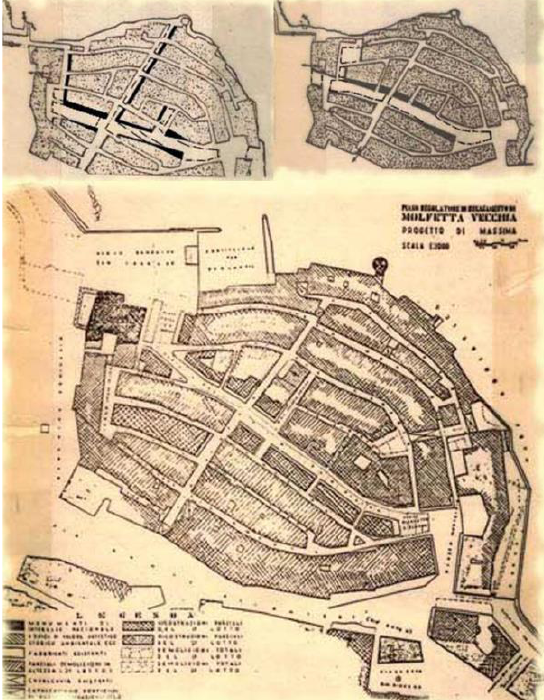
Figure 4. Drawn of proposed variation of street asset during